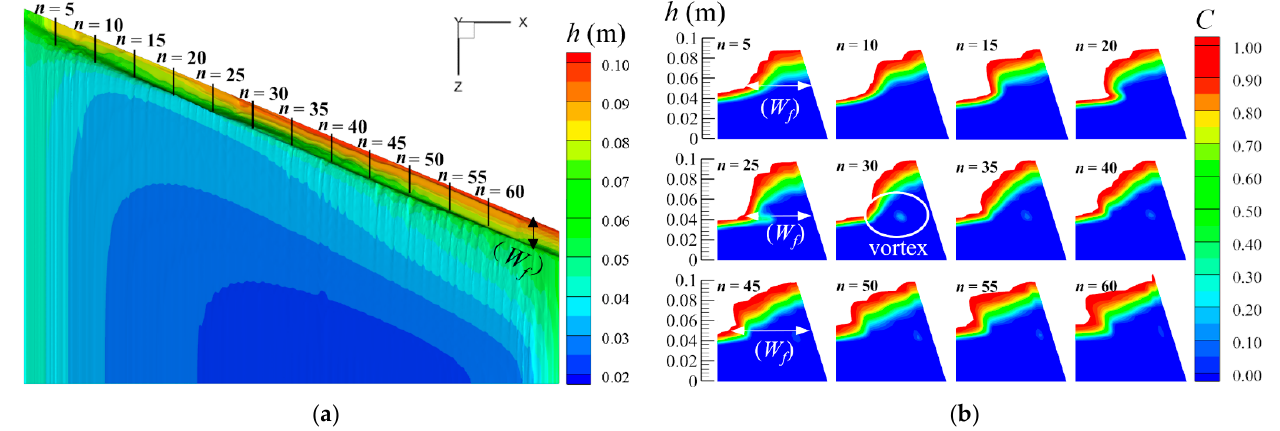
Figure 4. Standing wave above free-surface of skimming flow along the converging stepped spillway with θ = 48.3°, B = 22.5 mm, h c / B = 3.36 and Φ = 22.6°: ( a ) top view, the color is coded by the flow depth h perpendicular to the pseudo bottom; ( b ) cross sections on the edge of several steps, the color is coded by the air concentration C .